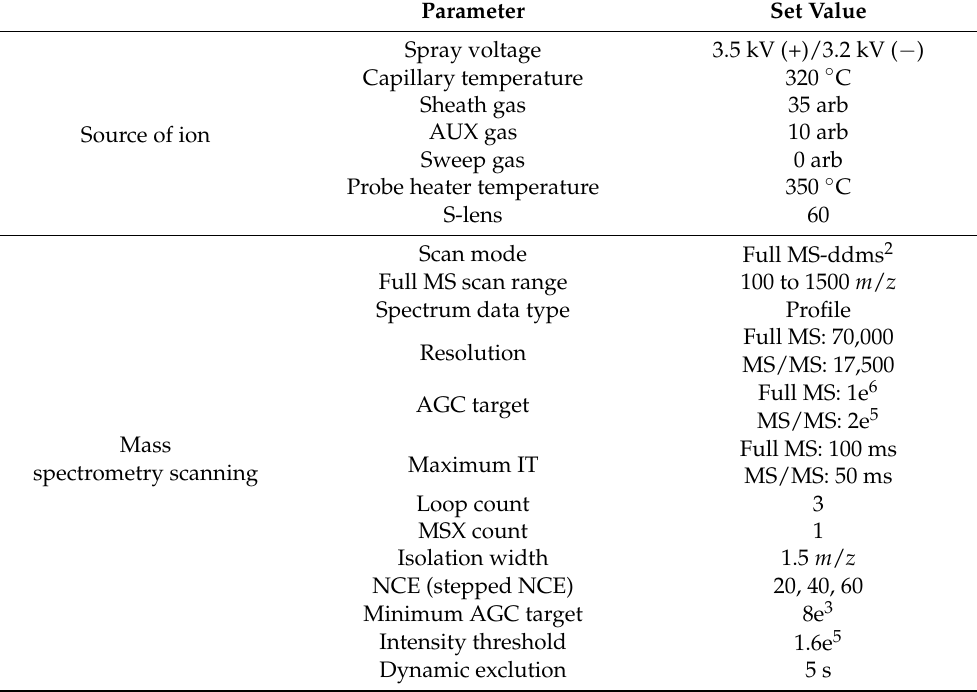
Table 1. Parameter setting of UPLC-Q-Exactive